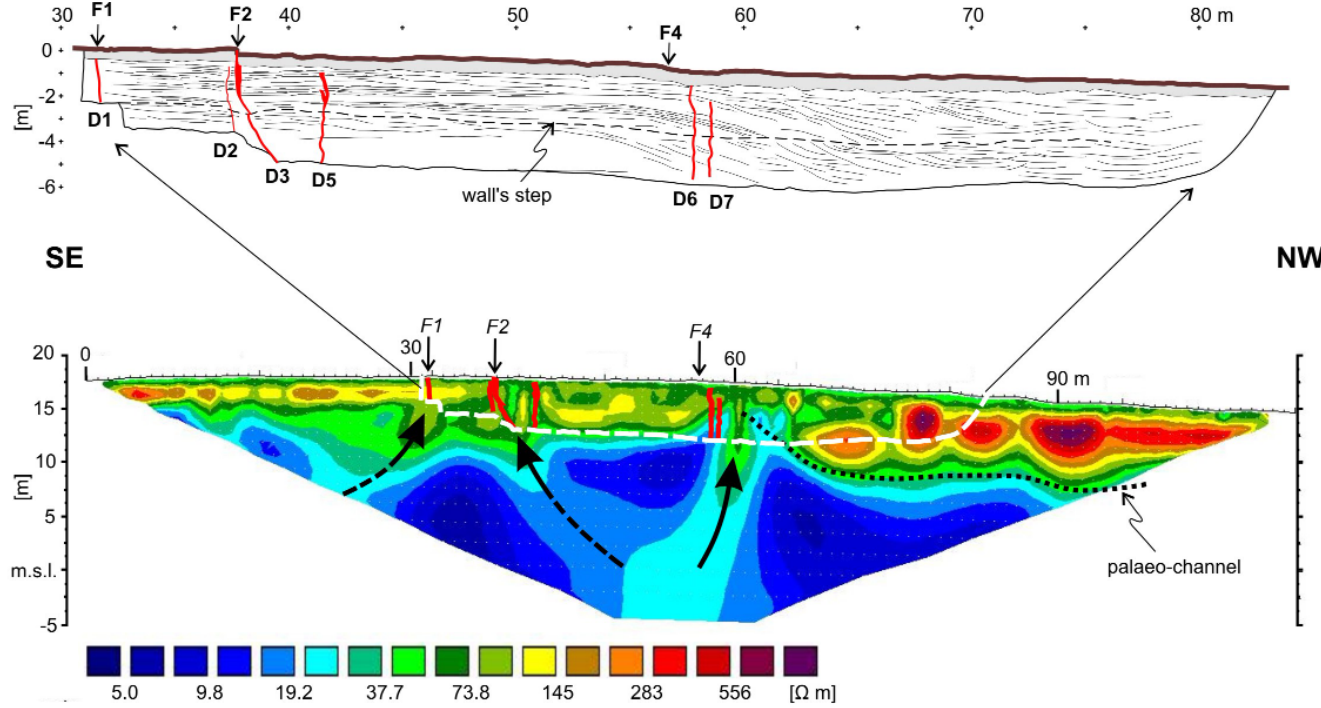
Figure 2. Two-dimensional resistivity model reconstructed at site 1 (bottom) compared to a simplified stratigraphic section (top) obtained from direct observations of the southern wall of the paleoseismological trench (Caputo et al. 2012). Red lines represent the sandy dykes observed in the trench (D1- D6) and associated with paleoliquefaction events. F1, F2 and F4 indicate the positions of the seismically induced fractures due to the May 20, 2012, Emilia- Romagna earthquake, as a consequence of lateral spreading. The high-resistivity body located beneath the northwestern part of the profile corresponds to the sandy infilled river bed of the paleo-Reno River. The large black arrows suggest the mobilisation pathways of the liquefied material in the subsoil.